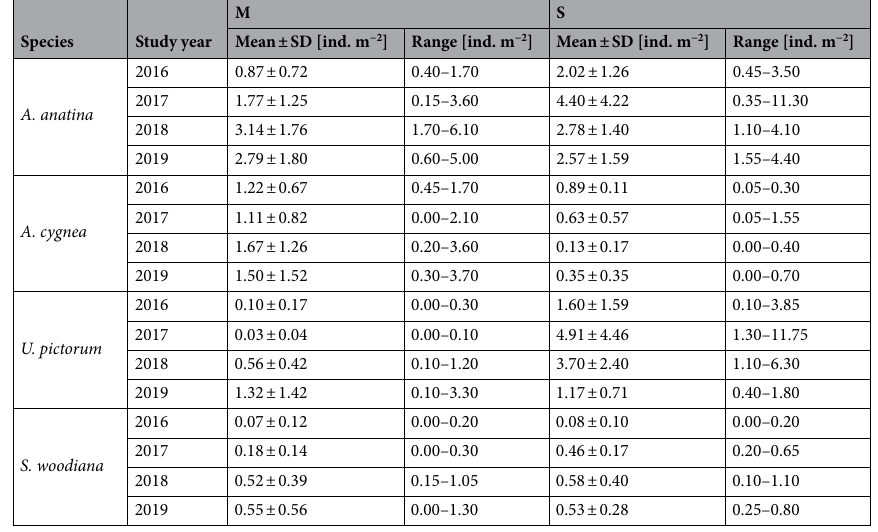
Table 3. Summary statistics of mussel densities at sites with muddy (M) and sandy (S) bottom. Number of sites with a muddy bottom, 2016: 3, 2017: 5, 2018: 5, 2019: 4. Number of sites with a sandy bottom, 2016: